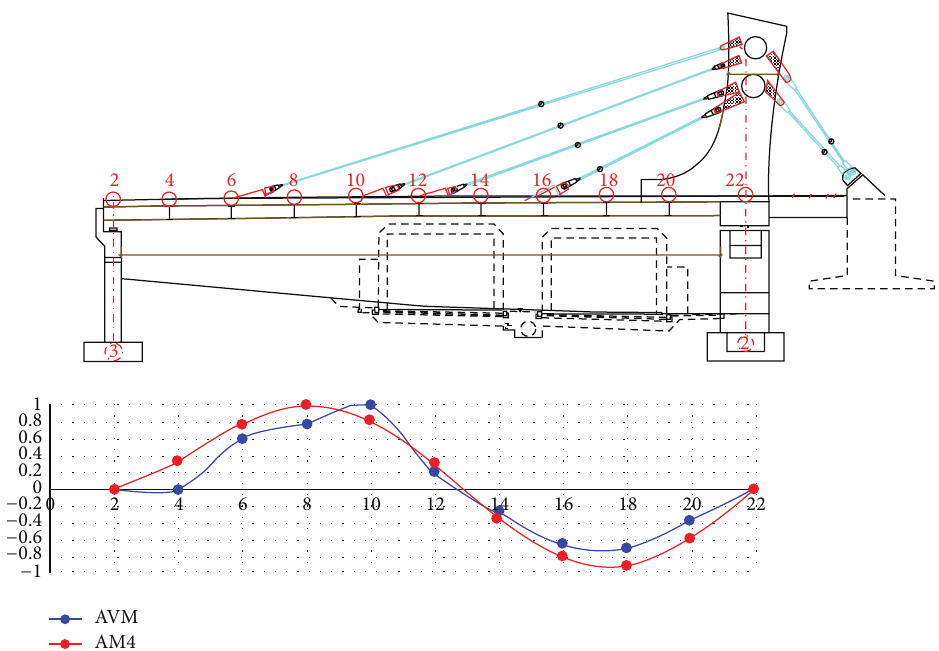
Figure 36: Experimentally and mathematically identified second mode